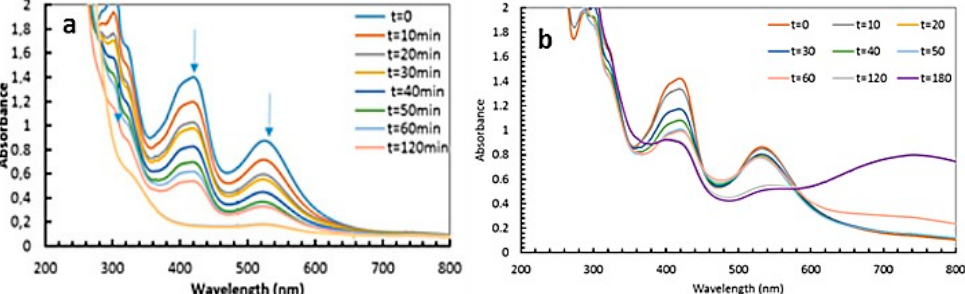
Figure 4. Temporal evolution of the UV-visible spectra of deaerated aqueous solutions containing 5 × 10 − 4 M sodium thiosulfate and 5 × 10 − 4 M potassium hexacyanoferrate under Xe lamp irradiation (equipped with an optical cutoff filter at 450 nm) ( a ) in the presence of 15 nm Au-NPs@citrate and ( b ) 30 nm Au-NPs@citrate. Optical path length: 1 cm.